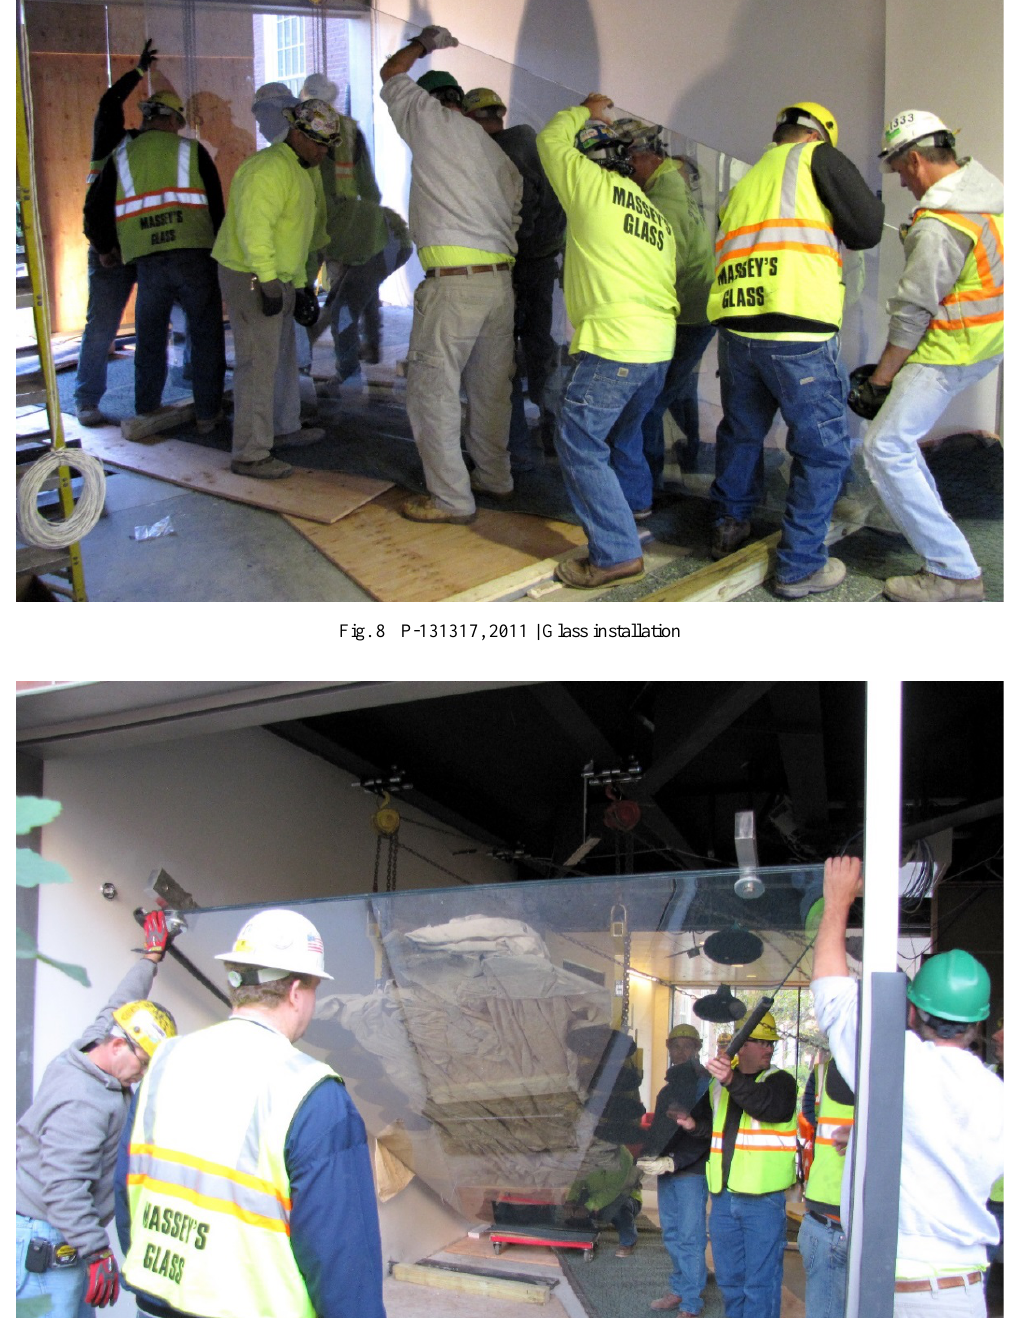
Fig. 9 P-131317, 2011 | Glass